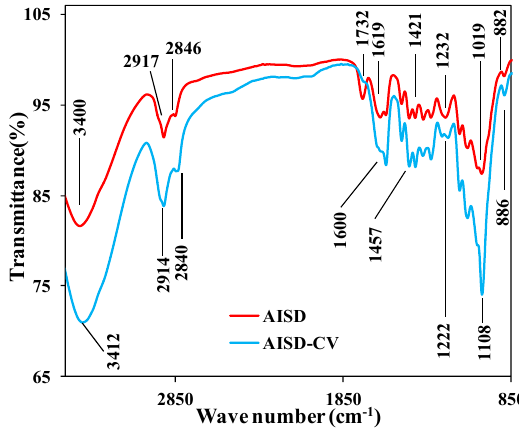
Figure 5. FTIR spectra of AISD and AISD − CV.